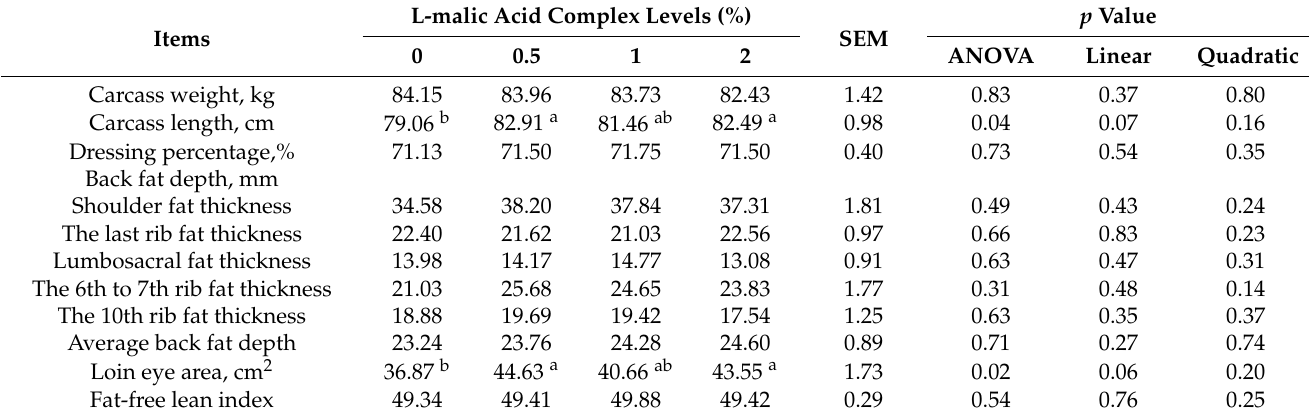
Table 3. Effects of dietary supplementation with L-malic acid on the carcass traits of finishing pigs ( n =